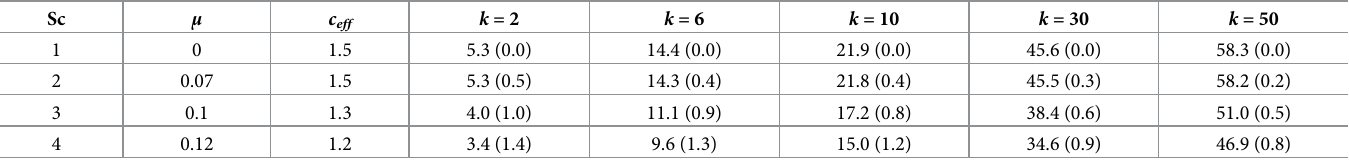
Table 1. Description of simulation